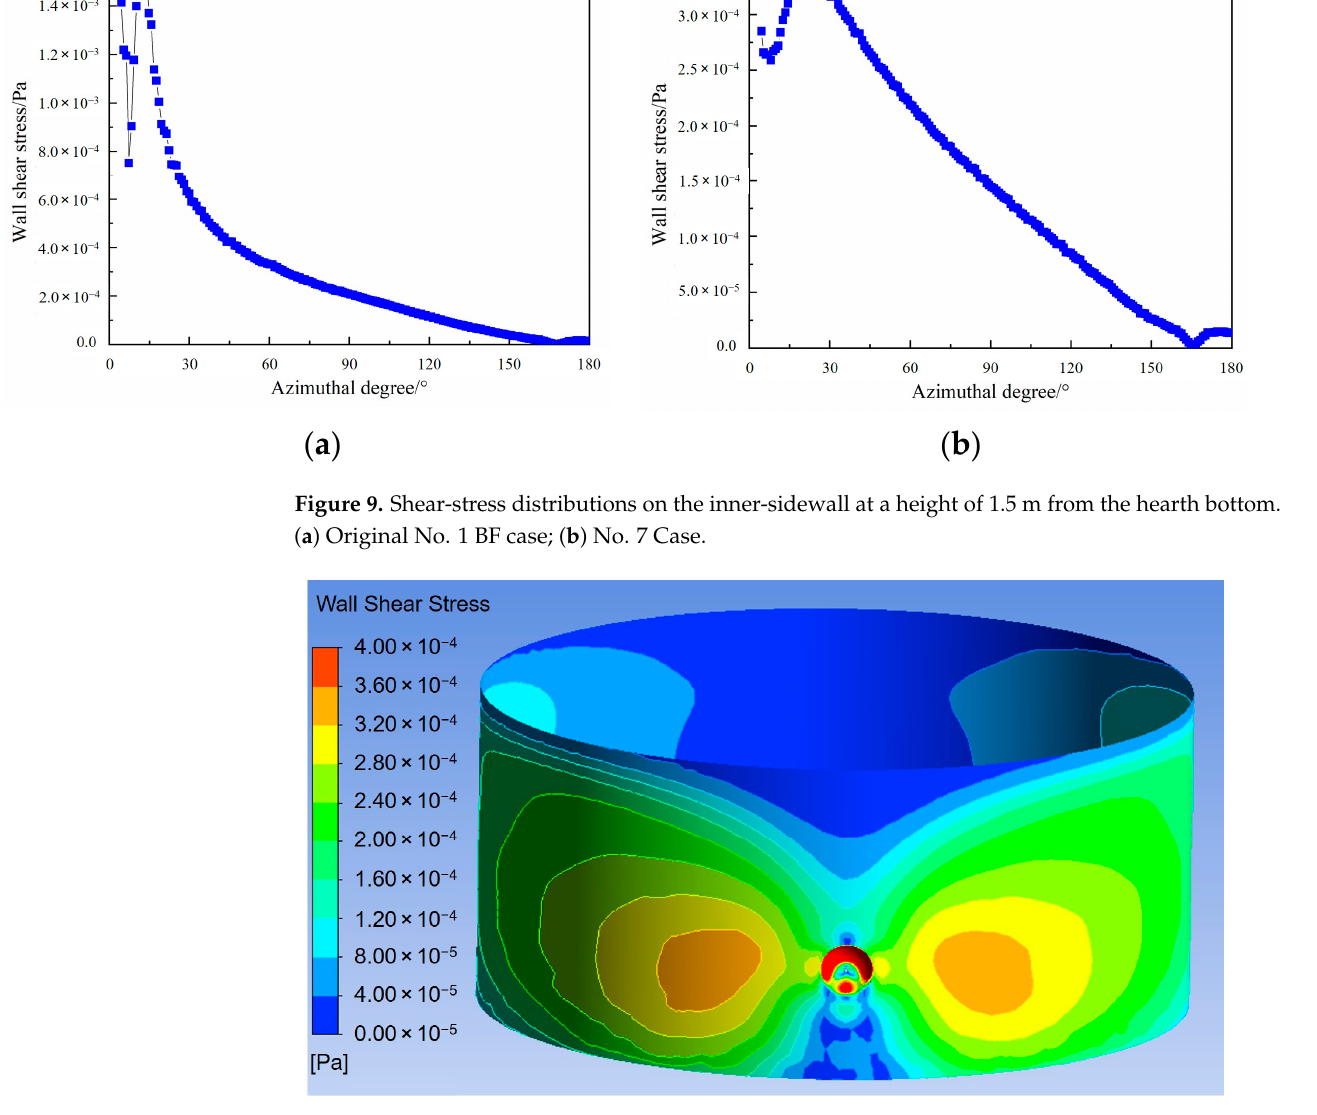
Figure 10. Shear-stress distribution on the inner-sidewall of the hearth in the No. 7 case.